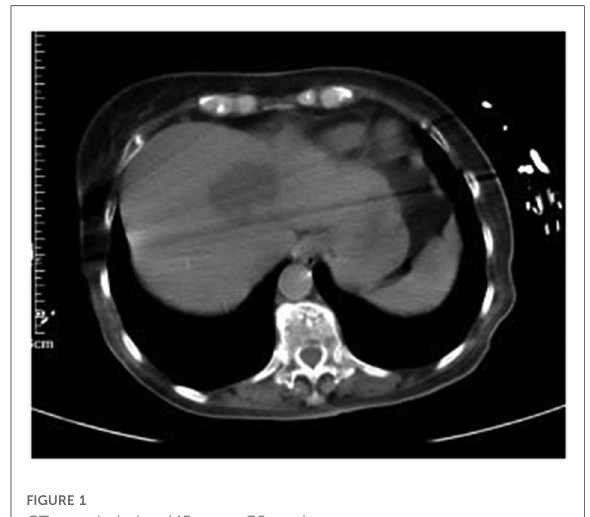
FIGURE 1 CT on admission (45 mm×38